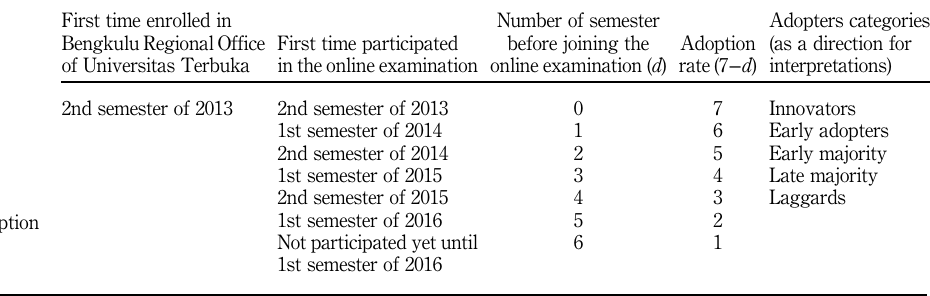
Table I. Relationship adoption rate and adopter